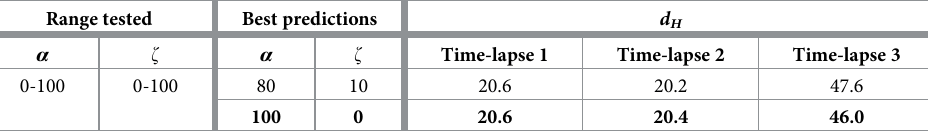
Table 1. Two best predictions for variations in α and z . The grid search results for the two best fits for three different experiments. The variable which provides the smallest d H for all cases was selected (bold).